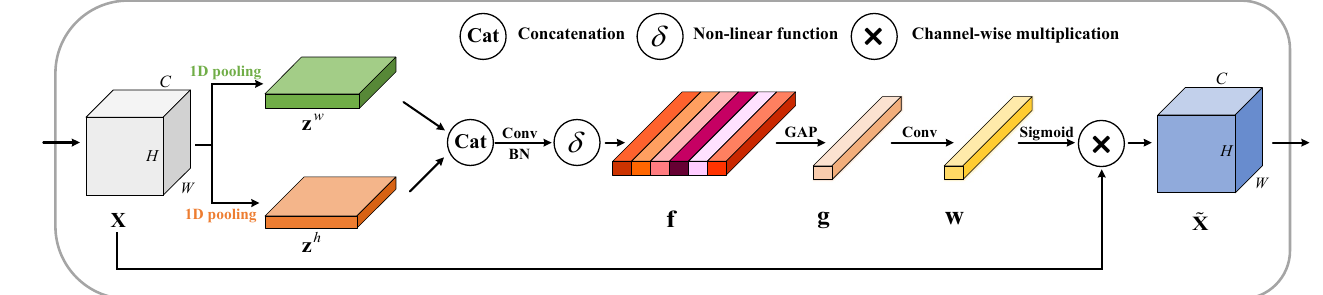
Figure 6. The design of the spatial insertion attention (SIA) module. “Conv” and “GAP” represent a convolutional layer and a global average pooling layer. “BN” denotes batch normalization.“Sigmoid” is activation